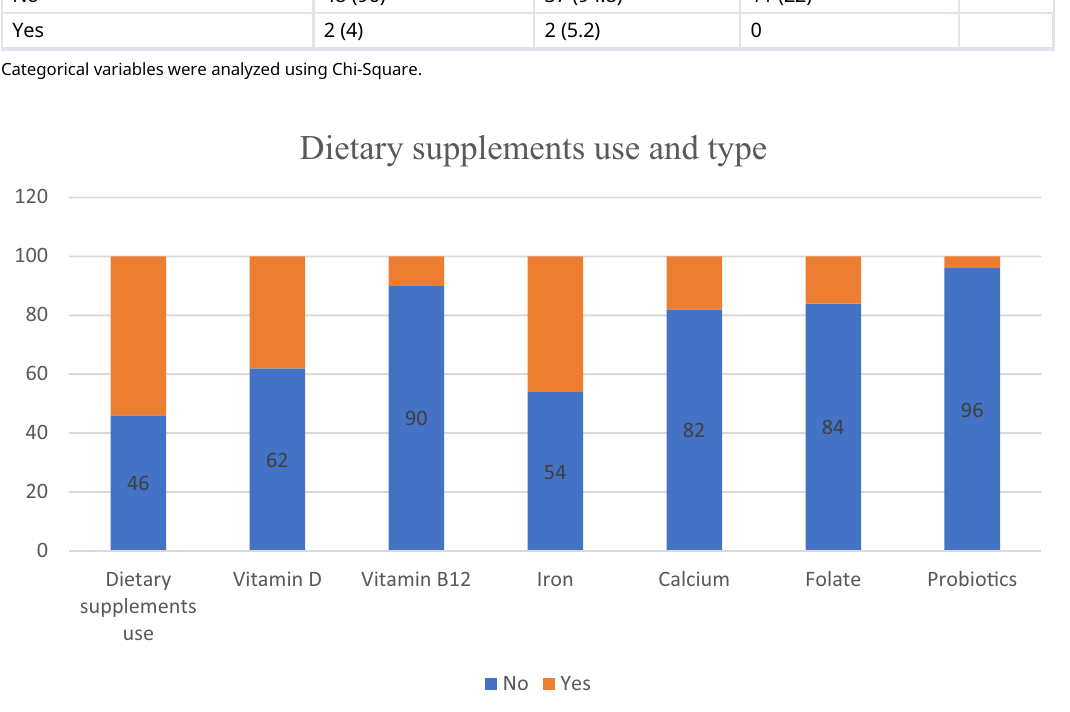
Figure 1. Dietary supplements use and type among study